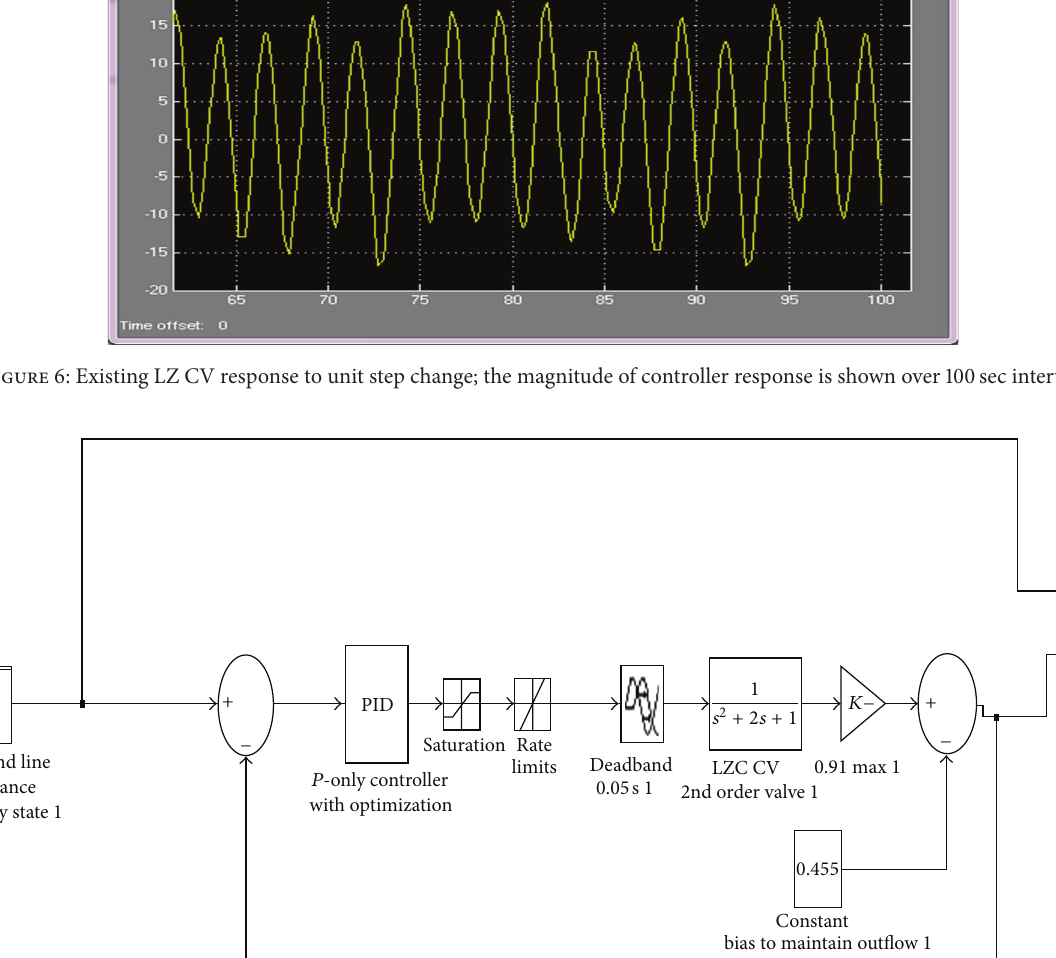
𝑃 -only controller